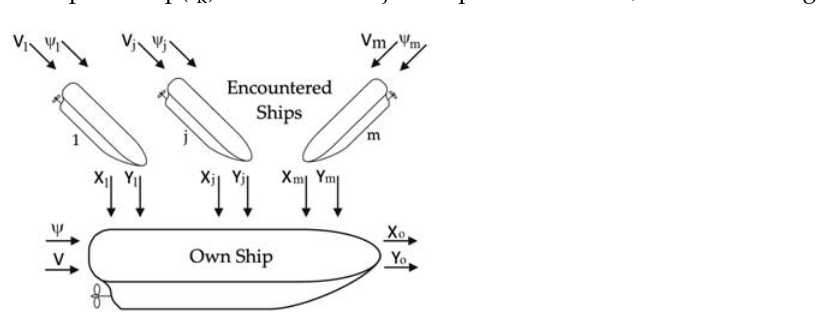
Figure 1. The process of controlling moving ships: (V, ψ )—speed and course of own ship, (V j , ψ j )—speed and course of encountered j ship, (X 0 , Y 0 )—coordinates of own ship position p, (X j , Y j )—coordinates of j encountered ship position p.